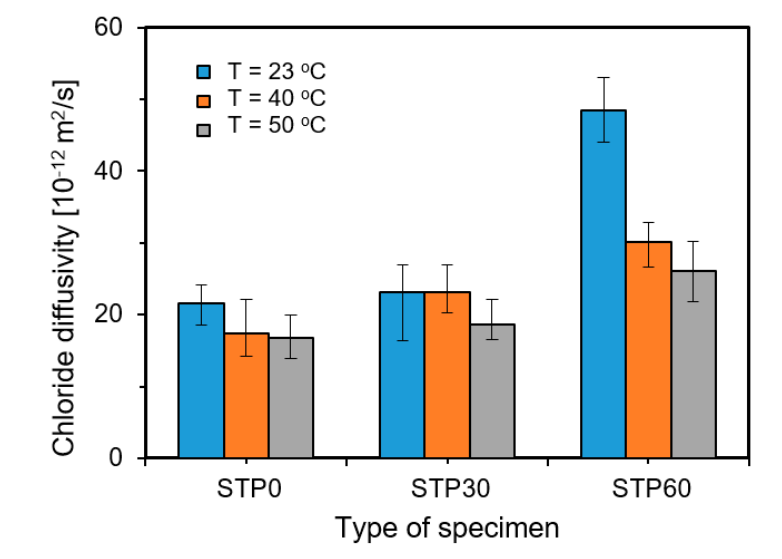
Figure 8. Chloride di ff usivity according to curing temperature (5% CO 2 ).